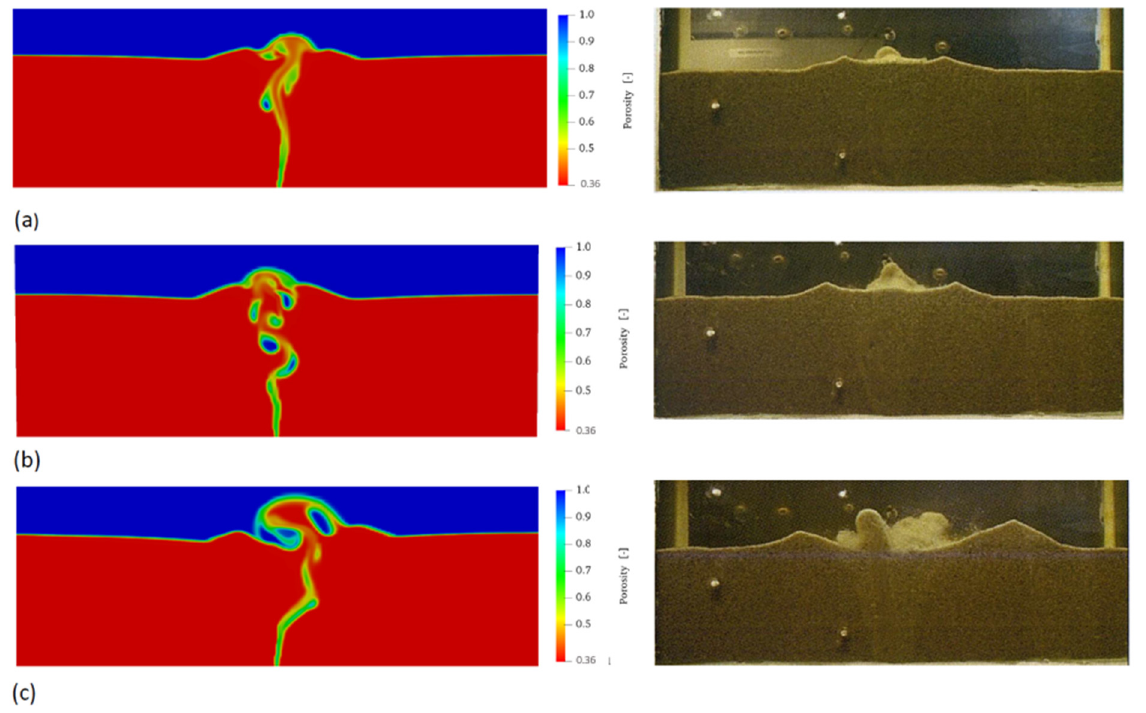
Figure 7. A comparison between the simulated sand boiling and the experimental photographs for flowrates ( a ) 700 L/h, ( b ) 900 L/h, and ( c ) 1200 L/h for bed height 150 mm and orifice opening 0.33 mm.